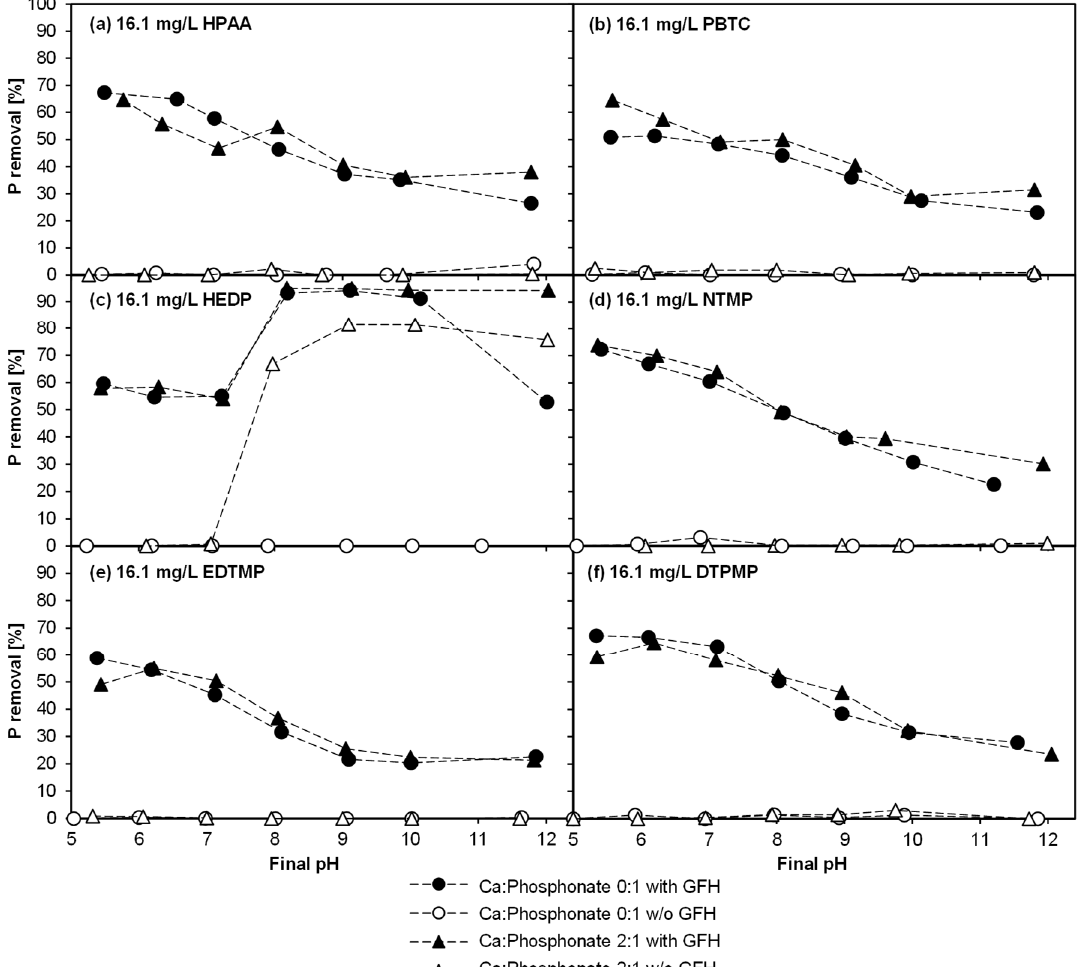
Figure 2. Influence of Ca II presence on phosphonate adsorption (T = 20 °C; t c = 7 d; initial phosphonate concentration = 16.1 mg / L; 0.2 g GFH / L and without GFH). ( a ) 16.1 mg / L HPAA, ( b ) 16.1 mg / L PBTC, ( c ) 16.1 mg / L HEDP, ( d ) 16.1 mg / L NTMP, ( e ) 16.1 mg / L EDTMP, ( f ) 16.1 mg / L DTPMP.